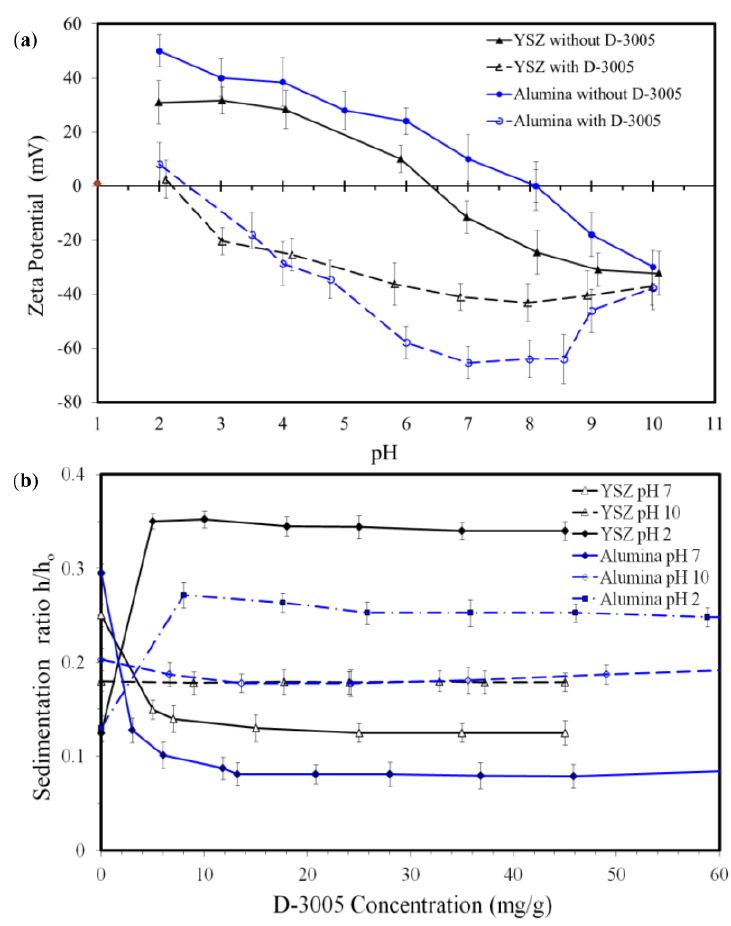
Figure 2. ( a ) Zeta potential and ( b ) sedimentation measurements with respect to pH and dispersant concentration for both YSZ and alumina.